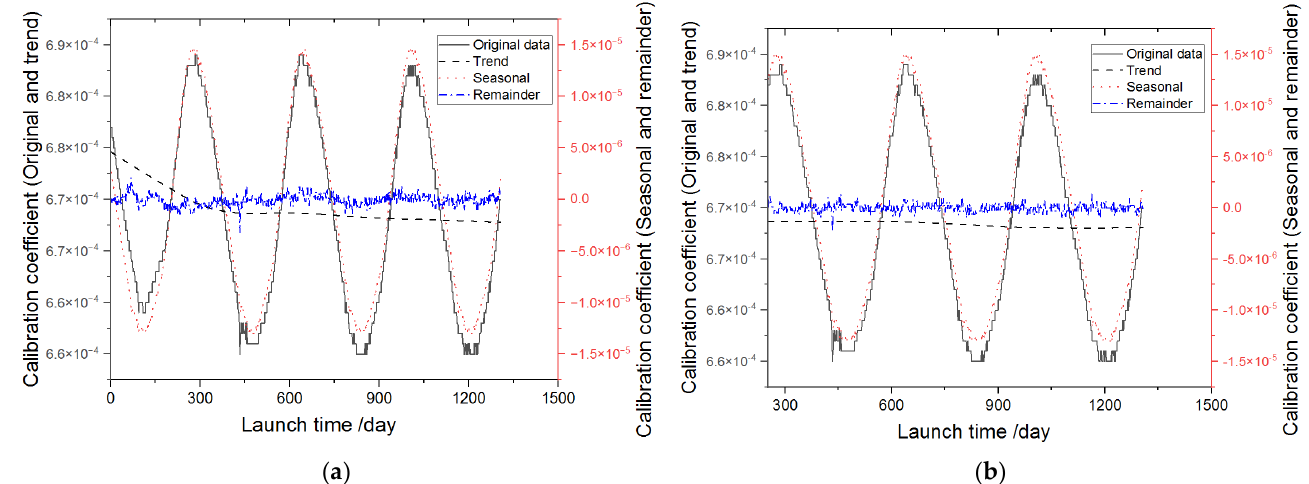
Figure 8. STL decomposition results of SCS 500 nm spectral band calibration coefficient. ( a ) For original calibration coefficient time series; ( b ) for calibration coefficients without the first 250 days of data.